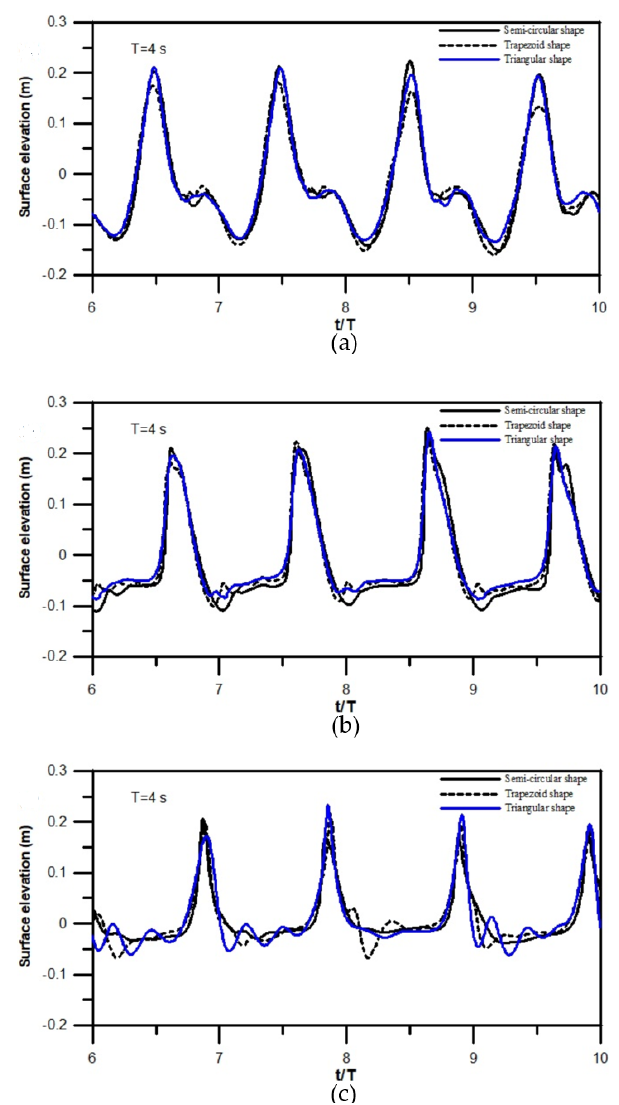
Figure 12. Time history of surface elevation with the incident wave height H i = 0.2 m and wave period T = 4 s at three wave gauges for the three types of breakwaters at the downstream distance ( a ) x = 18 m; ( b ) x = 20 m; ( c ) x = 22